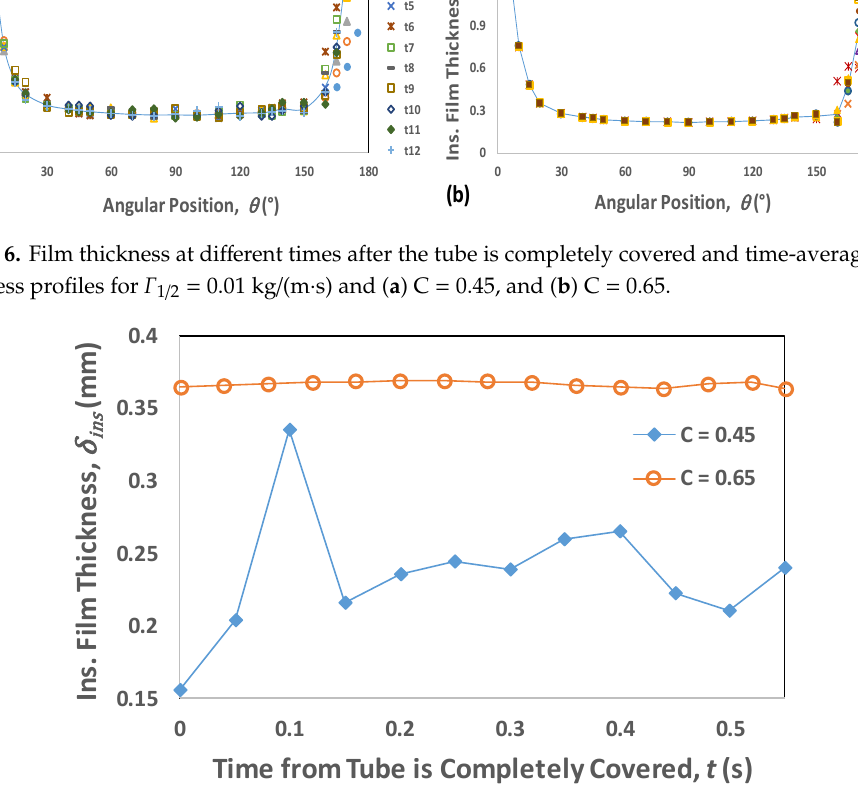
Figure 7. Instantaneous film thickness at θ = 90° for Γ 1 / 2 = 0.05 kg/(m·s).